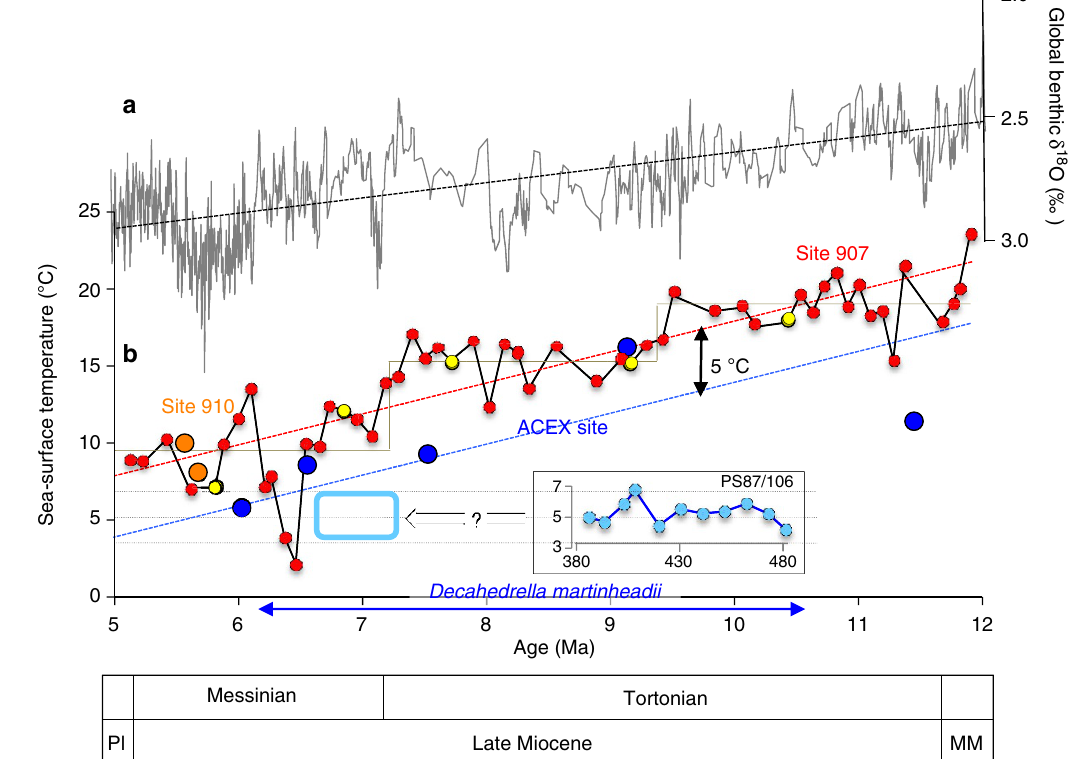
Figure 8 | Global climate (benthic d 18 O) stack and (sub-) Arctic SST records for the Late Miocene time interval. ( a ) Global benthic d 18 O stack from ref. 43. ( b ) Late Miocene (Messinian/Tortonian) alkenone-based U k ’ 37 -SST of Site 907 (yellow circles) 27 and this study (red circles; Supplementary Table 5), TEX 86 -SSTvalues of Site 910 (orange circles) 12 and alkenone-based U k ’ 37 -SSTof the ACEX Site (blue circles; this study/Supplementary Table 2). The ages of the five ACEX samples are based on 10 Be stratigraphy 73 . General cooling trends in the 907 SSTrecord (stippled red line), the ACEX SSTrecord (stippled blue line, assuming a parallel SST trend to Site 907 with an offset of about 5 (cid:2) C) and the benthic d 18 O record (stippled black line) are indicated. The alkenone-based U k ’ 37 -SST of Core PS87/106 are plotted versus depth (centimetres below seafloor) ( cf ., Supplementary Table 2). The stratigraphic range of the acritarch D. martinheadii in the sub-Arctic/Arctic realm is indicated 24,25 . As the central Arctic Ocean ACEX and the PS87/106 SST values should be similar, the PS87/106 record probably repesents a time span within the upper Tortonian to lower Messinian (light blue box). Pl, Pliocene; MM, Middle